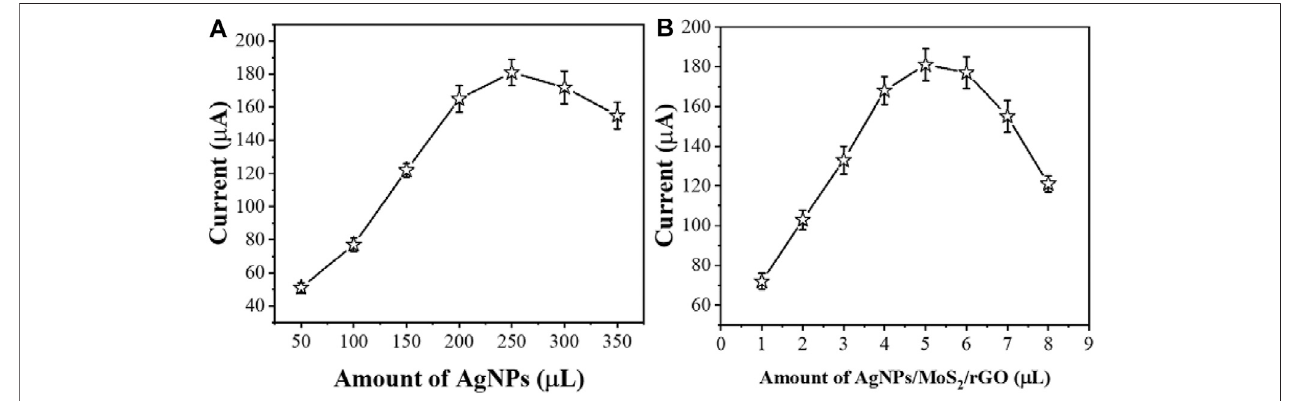
FIGURE 5 | The effect of (A) amount of AgNPs and (B) AgNPs/MoS 2 /rGO composite for sensing performance ( n ≥ 3).